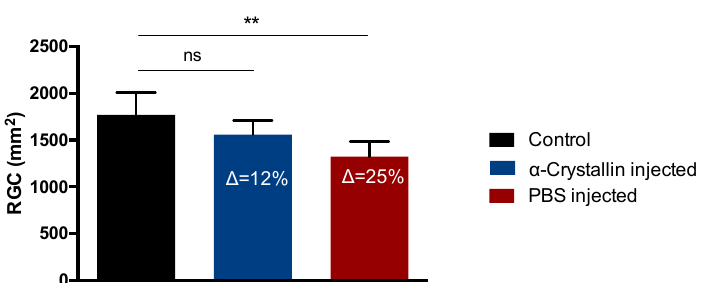
Figure 2. Quantification of RGC density in retinal flat-mounts. Elevation of the IOP resulted in an average loss of ∆ = 12% retinal ganglion cell (RGCs) in the α -crystallin B injected animals compared to the untreated contralateral eyes, while the RGC loss in the PBS-injected animals was about 25% (** p < 0.01, ns—not significant, n = 11, mean ± SD, one-way ANOVA). With respect to the RNFLT, there was a 6% decrease between the baseline measurement and the final measurement of the contralateral control eyes (53.18 ± 5.9 µm, 50.00 ± 5.7 µm, not significant), an 8% decrease within the crystallin-injected group (51.40 ± 4.8 µm, 47.60 ± 3.6 µm, not significant), and a 22% reduction of the RNFLT in the PBS-injected group (52.00 ± 2.6 µm, 40.75 ± 5.4 µm, p < 0.01) (Figure 3).